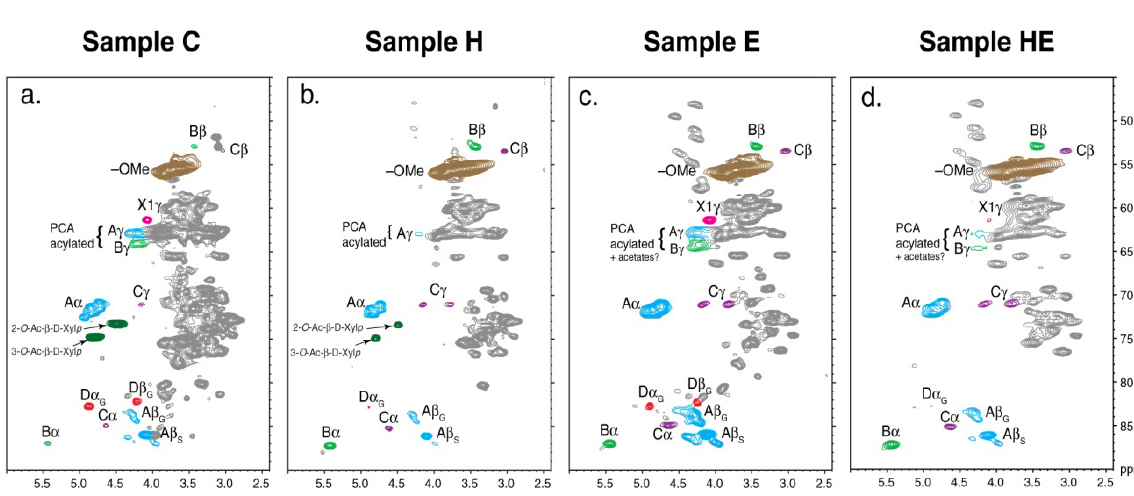
Figure 16. The aliphatic region ( a – d ), polysaccharide anomeric region ( e – h ), and aromatic region ( i – l ) of 13 C– 1 H correlation (HSQC) spectra of wheat straw. The spectra are aligned